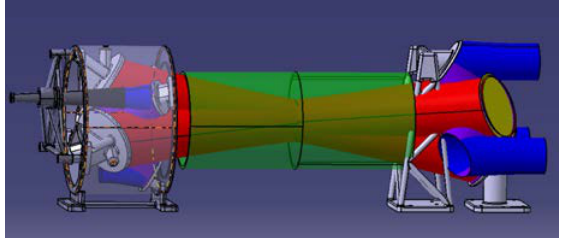
Fig. 4. CAD drawings of the ITER CTS prototypes of the closure plate coupling system for three receiver beams. The green duct represents the 400 mm long vacuum window assembly.